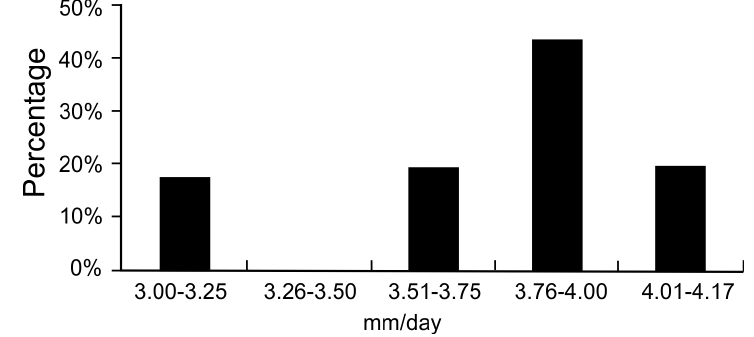
Figure 5. Scar distribution according to the average rainfall rate.